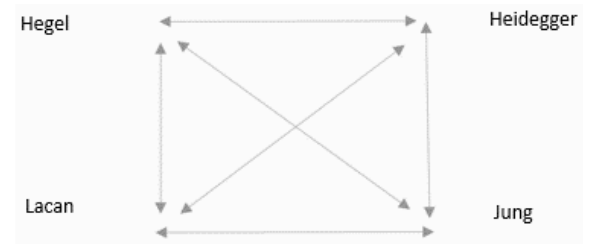
Figure 4. Semiotic Square.